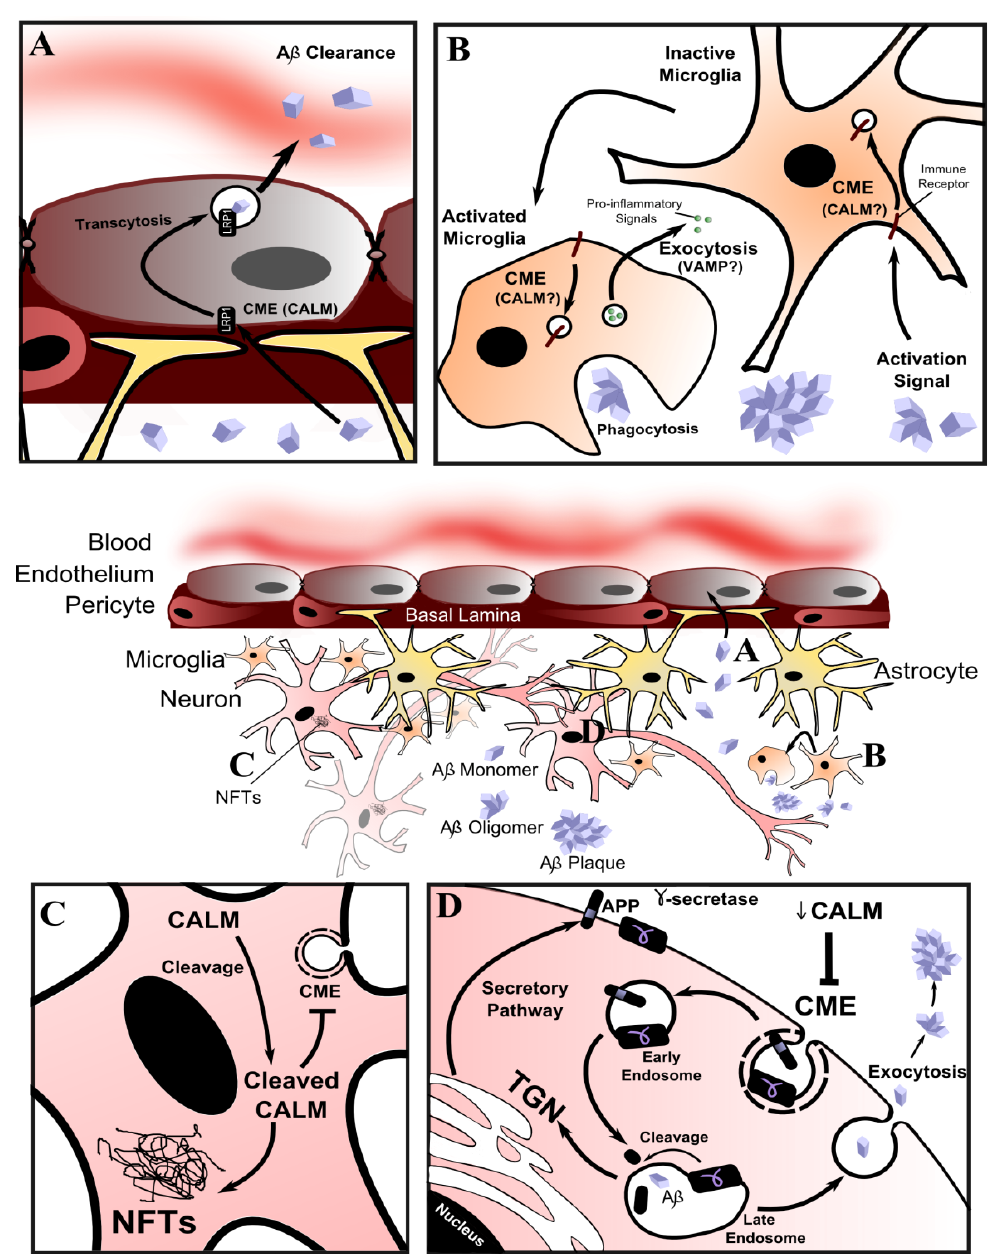
Figure 4. Current hypotheses of the mechanism of CALM involvement in late onset Alzheimer’s disease (LOAD). ( A ) CALM may influence the efficiency of A β clearance into the bloodstream [127–129], possibly by changing the LRP1 and CME dependent brain-to-blood transcytosis of A β ; ( B ) CALM is highly expressed in microglia in individuals with LOAD [127]. CALM dysfunction in microglial cells of the innate immune system may affect immune system signaling and A β clearance; ( C ) CALM is cleaved in LOAD brain tissue and associated with hyper-phosphorylated tau in neurofibrillary tangles (NFTs) [127]; ( D ) CALM may be involved in A β generation by influencing amyloid precursor protein (APP) processing. Altered CALM function/expression could change the steady-state localization of APP and γ -secretase via CME and thus alter the rate of APP cleavage and production of A β . In this latter hypothesis, decreased CALM expression might be protective. Conflicting evidence relates the level of CALM expression to the production of A β